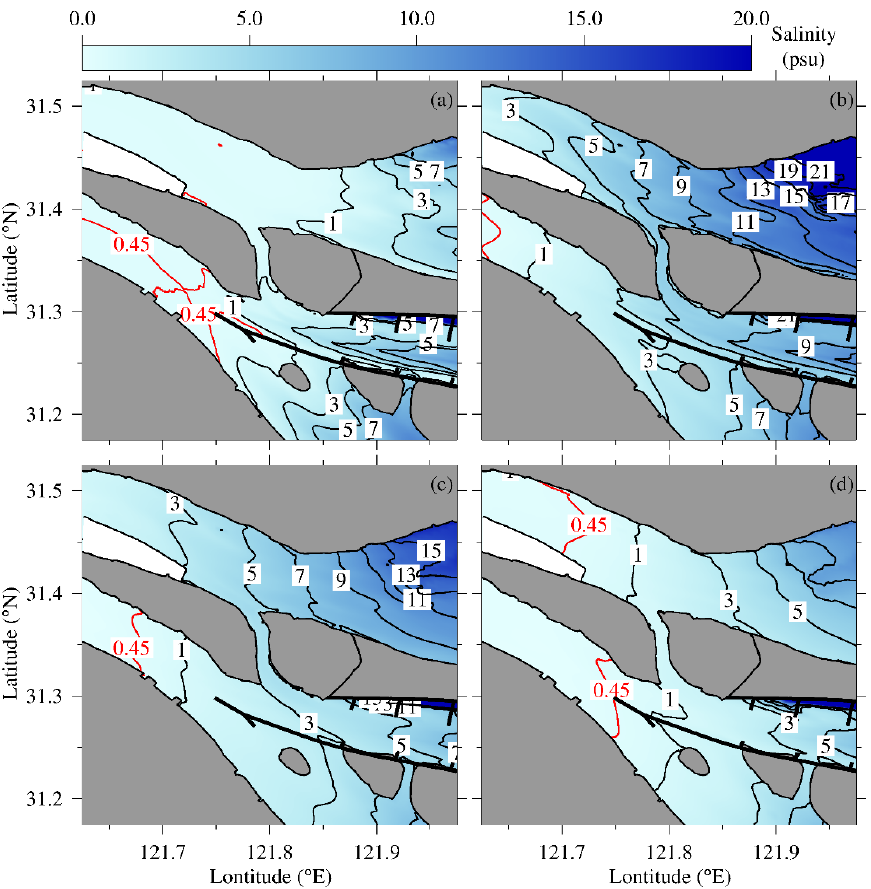
Figure 12. Vertically and tidally averaged salinity fields during neap tide ( a ), middle tide after neap tide ( b ), spring tide ( c ) and middle tide after spring tide ( d ) in EX2.